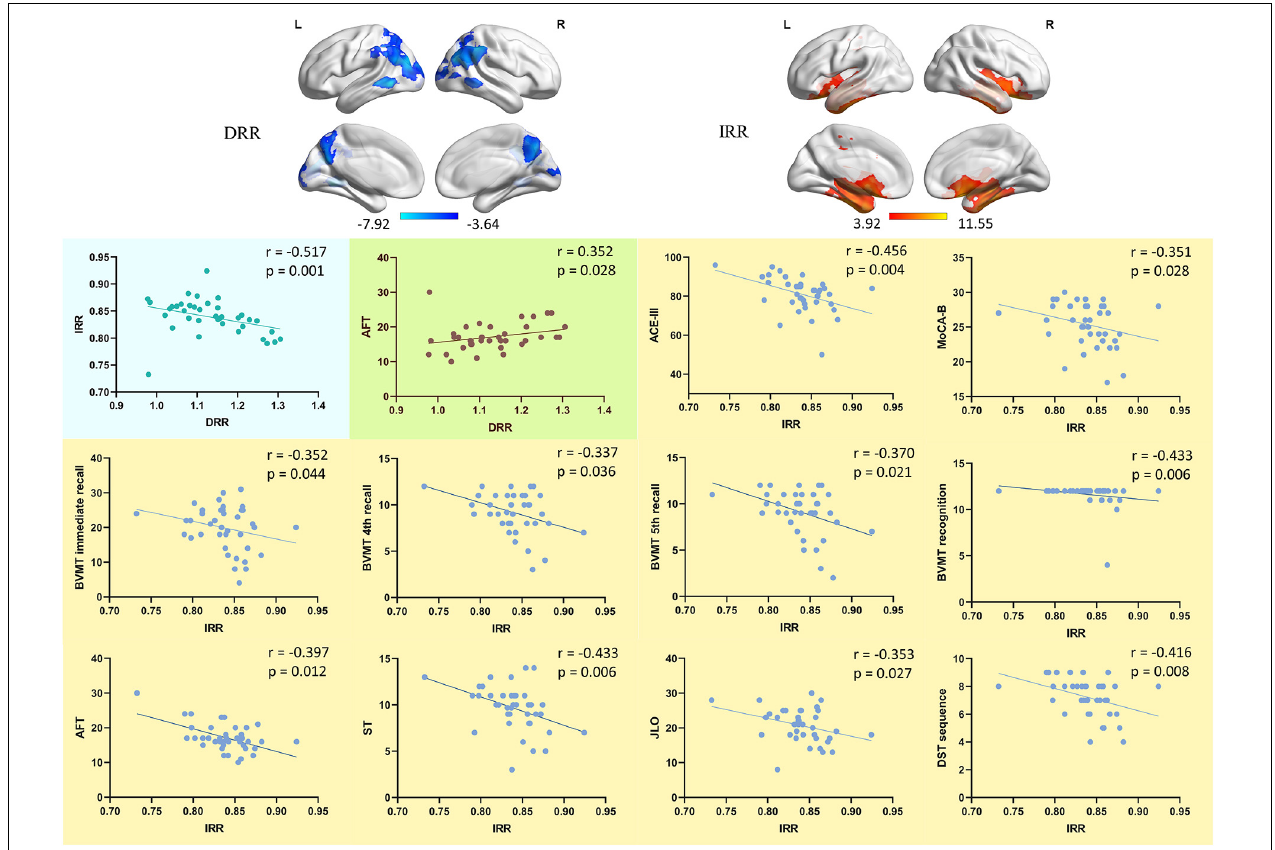
FIGURE 4 | The correlation of DRR/IRR and neuropsychological performance. The correlation between the ReHo value of DRR/IRR and the neuropsychological tests performance. DRR, decreased ReHo region. IRR, increased ReHo region. ACE-III, Addenbrooke’s Cognitive Examination. MoCA-B, Montreal Cognitive Assessment-Basic. BVMT, Brief Visuospatial Memory Test. AFT, Animal Verbal Fluency Test. ST, Silhouettes Test. JLO, Judgment of Line Orientation. DST, Digit Span Test.